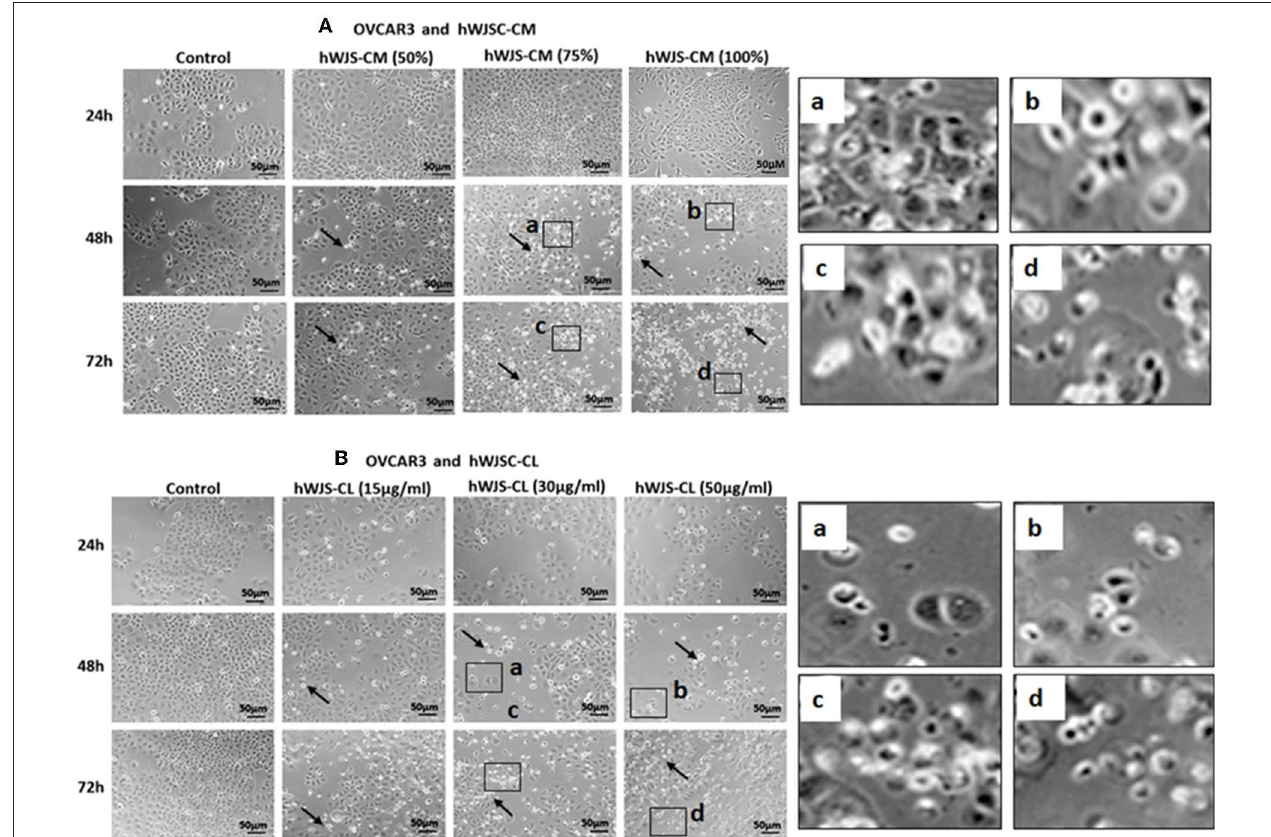
FIGURE 4 | Representative phase contrast images of OVCAR3 cells treated with hWJSC-CM (A) and OVCAR3 cells treated with hWJSC-CL (B) . There were more cell death and decreases in OVCAR3 cells treated with increasing concentrations of hWJSC-CM and hWJSC-CL with time. Thin black arrows indicate dead translucent cells; The magnified images (a–d) represent the respective boxed area (a–d) within the main figure and shows decrease in the size of cells, membrane damages and condensed or fragmented nuclei. hWJSC-CM: human Wharton’s jelly stem cells conditioned medium; hWJSC-CL: human Wharton’s jelly stem cell lysate.